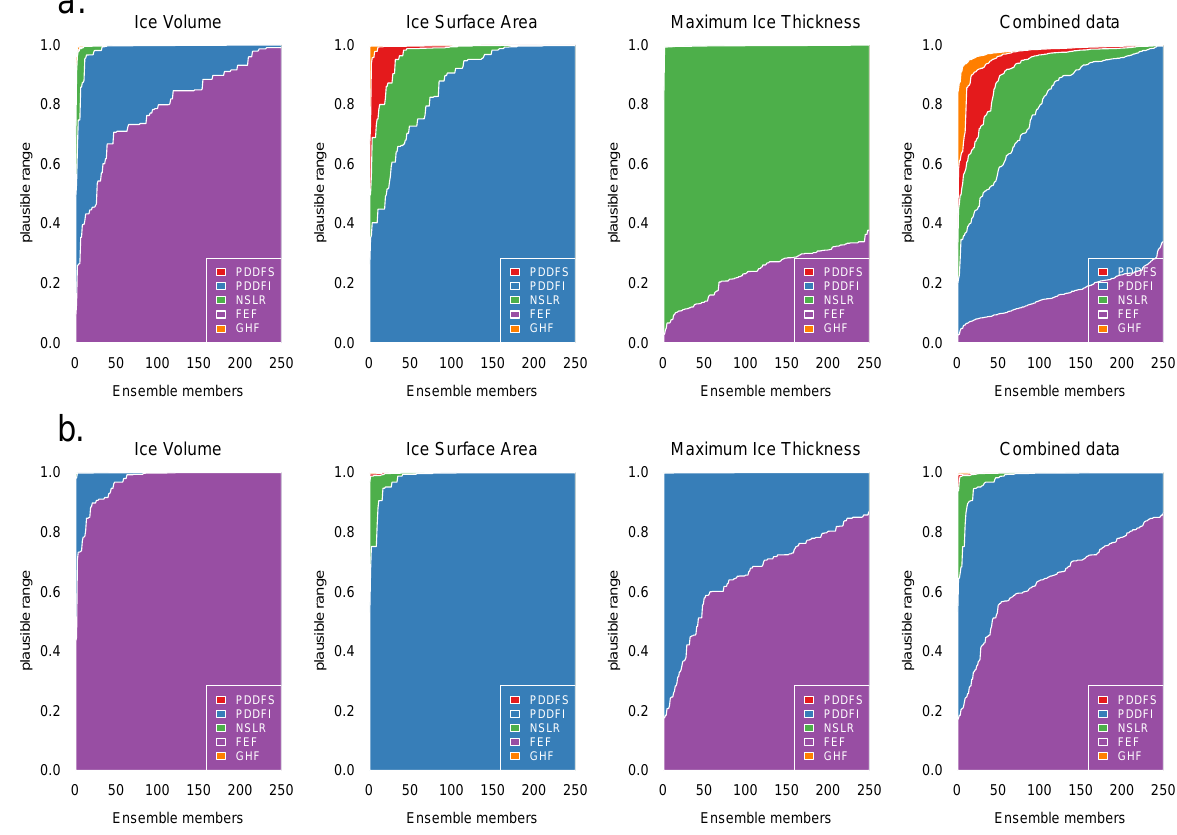
Fig. 7. The “not implausible” range of each input, R (a) assuming no observational or simulator discrepancy uncertainty and (b) with 10% of maximum observational uncertainty (1 standard deviation). The “not implausible” range R across the ensemble is measured on the y axis of each plot, where different colours represent the input parameters. R varies according to ensemble member, with the ensemble members sorted from lowest to highest R , separately for each parameter. Individual plots represent the constraint using a single data summary, with the final plot in each row representing the constraint using the maximum implausibility of all three data summaries combined. Plot colours are ordered by the mean constraint of each parameter. Table 2. The typical range of each marginal input range (%) ruled out as “implausible”, when using a particular simulator output. The number is the mean of the implausible range, taken across the ensemble. “COMBINED” indicates the constraint when the maximum implausibility from all data streams is